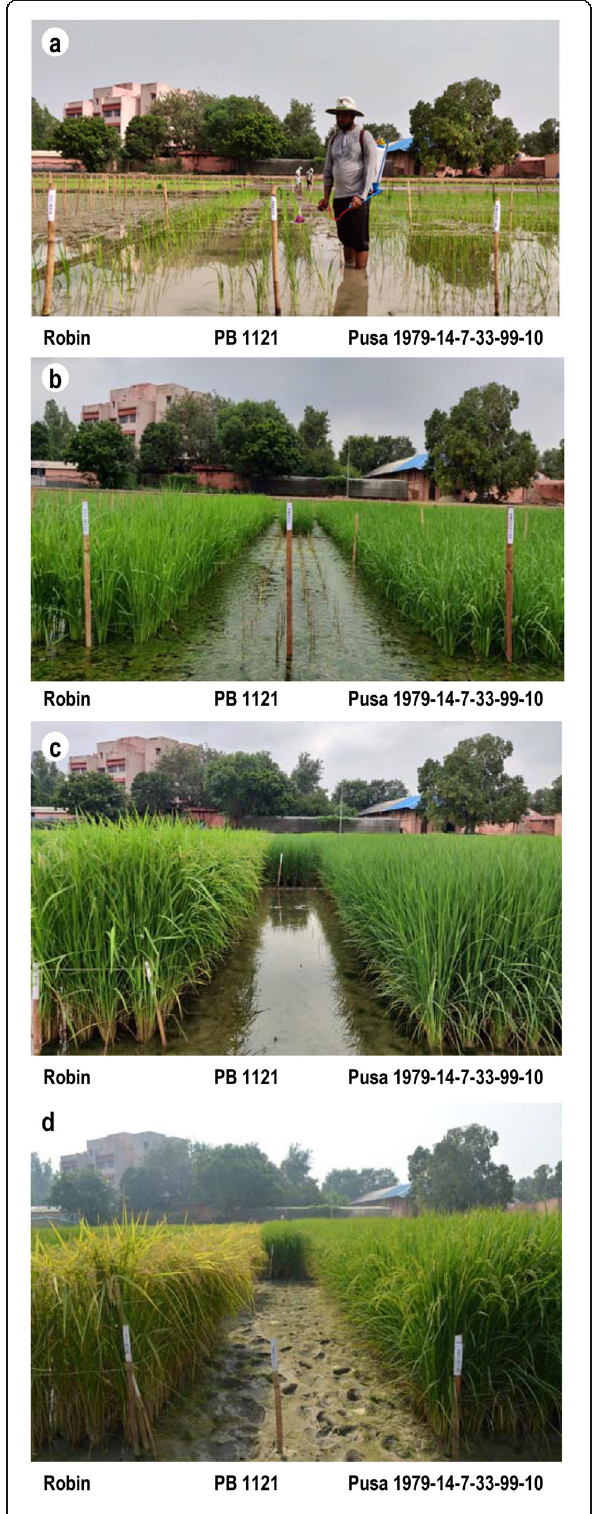
Fig. 6 Phenotypic screening of PB 1121-HT NILs along with Recurrent Parent (RP), PB 1121 and Donor Parent, Robin for tolerance to the herbicide, Imazethapyr, a application of Imazethapyr @ 2.5 ml/liter after 10 days of transplanting, b 20 days after herbicide spray showing that complete death of RP, c 60 days after herbicide spray, d 90 days after herbicide